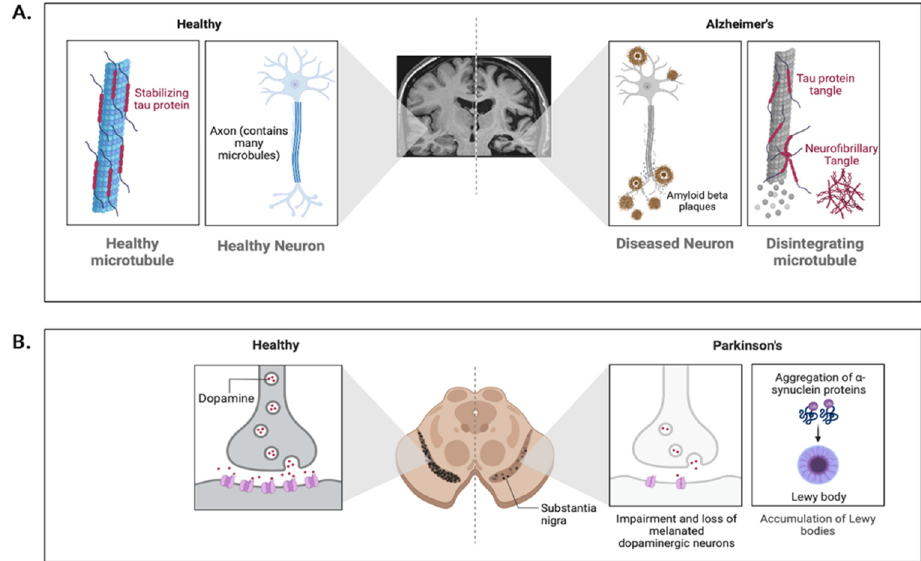
Figure 2. Abnormal Protein Aggregations in Alzheimer’s and Parkinson’s Disease. ( A ) Healthy neu- rons are supported internally by microtubules which are stabilized by the protein tau. In Alzheimer’s disease, abnormal accumulations of amyloid-beta are present which form plaques around neurons. The increase in amyloid-beta plaques causes an upregulation of abnormal conformations of tau which detach from microtubules and bind to other tau molecules forming neurofibrillary tangles. The increase in amyloid-beta plaques and neurofibrillary tangles severely impairs cell functioning and causes apoptosis. ( B ) Parkinson’s disease is characterized by the loss of dopaminergic neurons in the substantia nigra pars compacta. The loss of dopaminergic neurons is caused by Lewy body inclu- sions which consist of abnormal aggregations of alpha-synuclein. Lewy bodies drastically decrease dopamine synthesis by decreasing the synthesis and activity of tyrosine hydroxylase, a precursor to dopamine ( A ) adapted from “Alzheimer’s disease 2”, by Biorender.com (accessed on 16